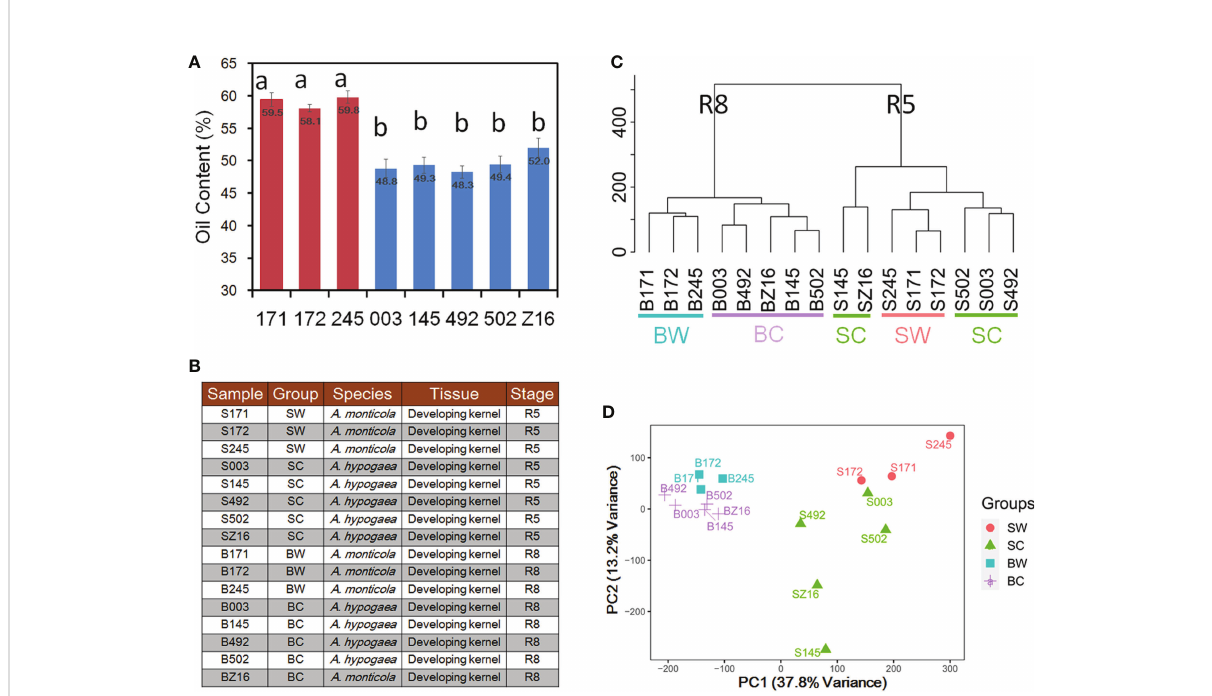
FIGURE 1 Analysis of wild and cultivated peanuts at two seed developmental stages. (A) Seed oil content of three wild and fi ve cultivated accessions. (B) Illustration of 16 samples for RNA sequencing (RNA-seq). Different letters indicated statistically signi fi cant differences in oil content between accessions according to Tukey ’ s range test at the 0.05 level. (C) Hierarchical clustering between 16 samples. (D) Principal component analysis (PCA) of gene expression pro fi les in 16 samples. SW and SC indicated seeds of wild and cultivated peanuts at the R5 stage, respectively. BW and BC denoted seeds of wild and cultivated peanuts at the R8 stage,